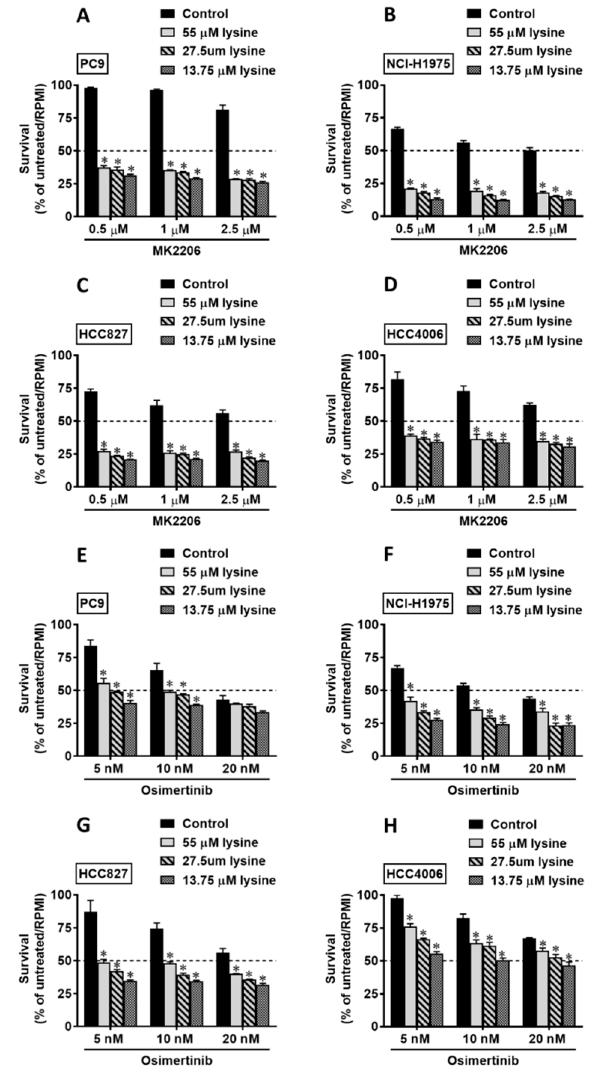
Figure 7. EGFR -mutant NSCLC cell survival strongly reduced under the combined treatment of MK2206 and osimertinib with lysine reduction. ( A ) PC9; ( B ) NCI-H1975; ( C ) HCC827; and ( D ) HCC4006 cells were incubated with lysine-deprived media containing 55, 27.5, and 13.75 μ M lysine 0, 1, and 2.5 μ M MK2206. ( E ) PC9; ( F ) NCI-H1975; ( G ) HCC827; and ( H ) HCC4006 cells were incubated with lysine-deprived media containing 55, 27.5, and 13.75 μ M lysine along with 5, 10, and 20 nM osimertinib. The survival of each cell line was analyzed using an SRB assay. The results are representative data obtained from two independent experiments. The data are presented as the mean ± SEM (*, p < 0.05 compared with the control group); SRB, sulforhodamine